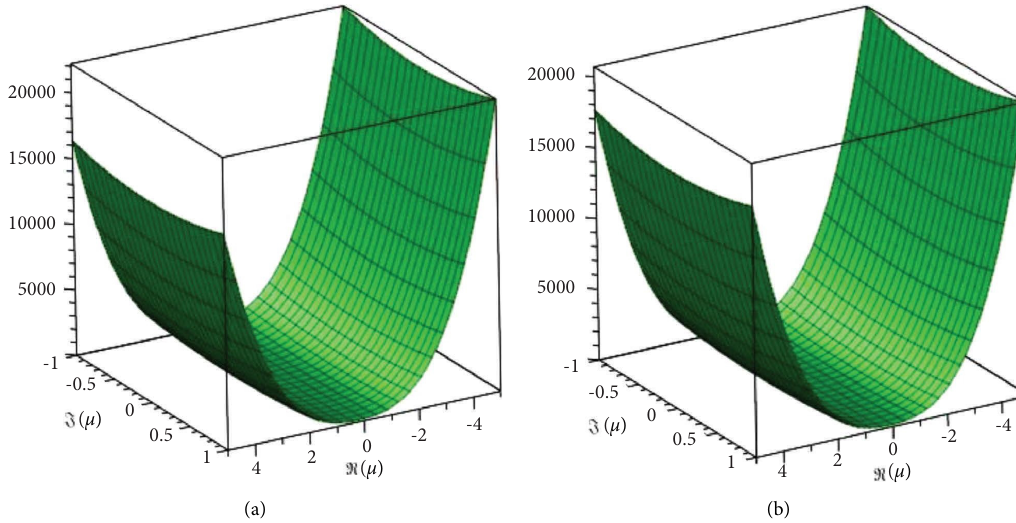
Figure 4: For varying Z and η values, the suspected cases is increasing gradually (a) A